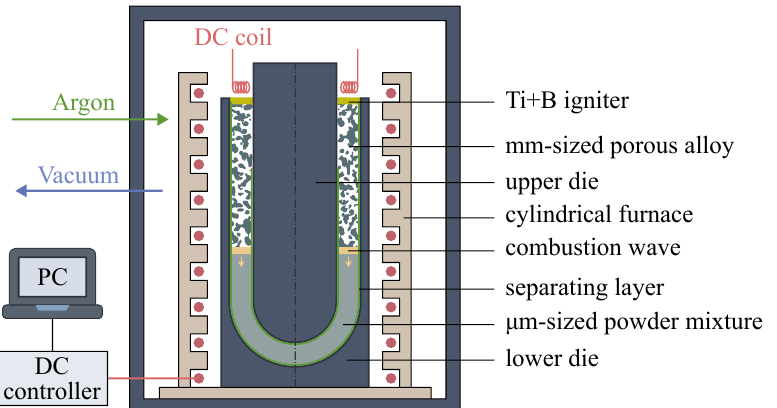
Figure 2. Schematic diagram of the experimental setup used for combustion synthesis of alloys. Synthesized emitter of the burner has a structure of highly permeable porous scaffold (resulting porosity of 0.55–0.60, the specific surface area below 10 − 3 m 2 /g) comprised of tightly fused mm-sized spherical-like intermetallic struts forming a net of mm-sized interconnected pore channels. For capturing the geometrical features of the porous scaffold, we used X-ray Computed Tomography to reconstruct a sample of the porous